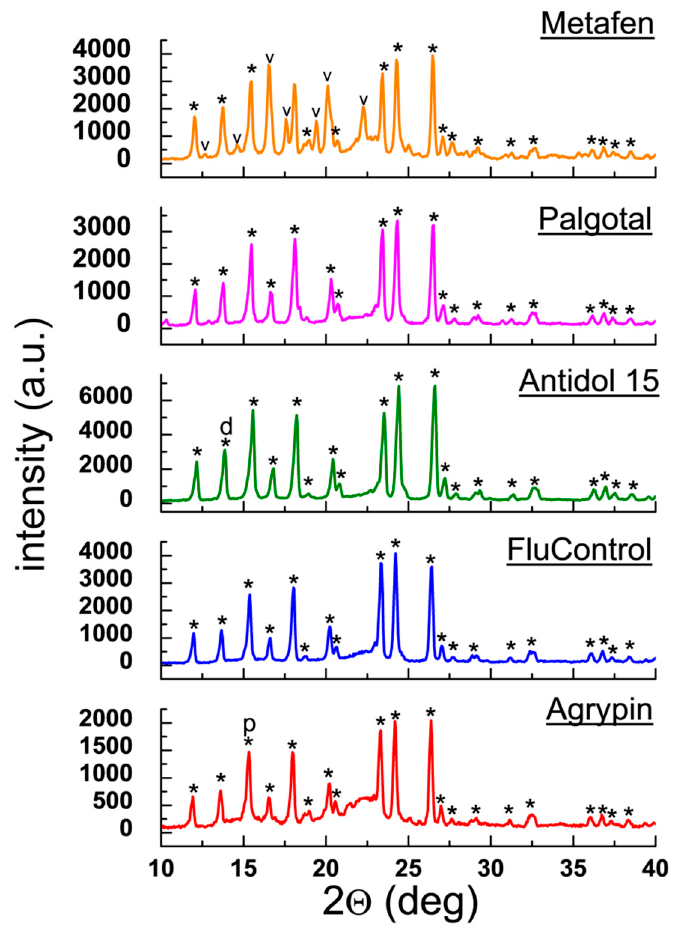
Figure 9. Diffraction patterns for the drugs Metafen, Palgotal, Antidol 15, FluControl and Agrypin. (* - acetaminophen, ∨ – ibuprofen, d – codeine phosphate and p – pseudoephedrine hydrochloride) Table 7. Analysed drugs containing ACP and pure ACP as a chemical reagent.